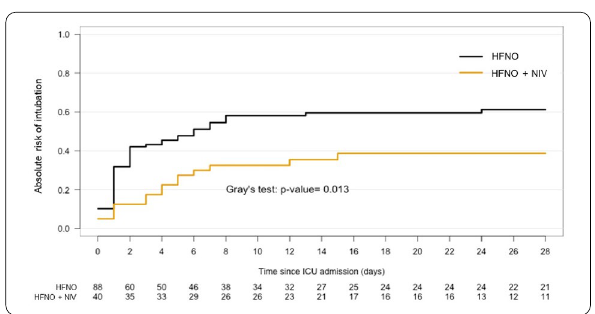
Figure 1. Cumulative incidence of intubation to day 28 in the high-flow nasal oxygen only and the additional face-mask noninvasive ventilation groups. Hazard ratio from a Cox model multivariate analysis in the whole population was 0.46 (95%CI,